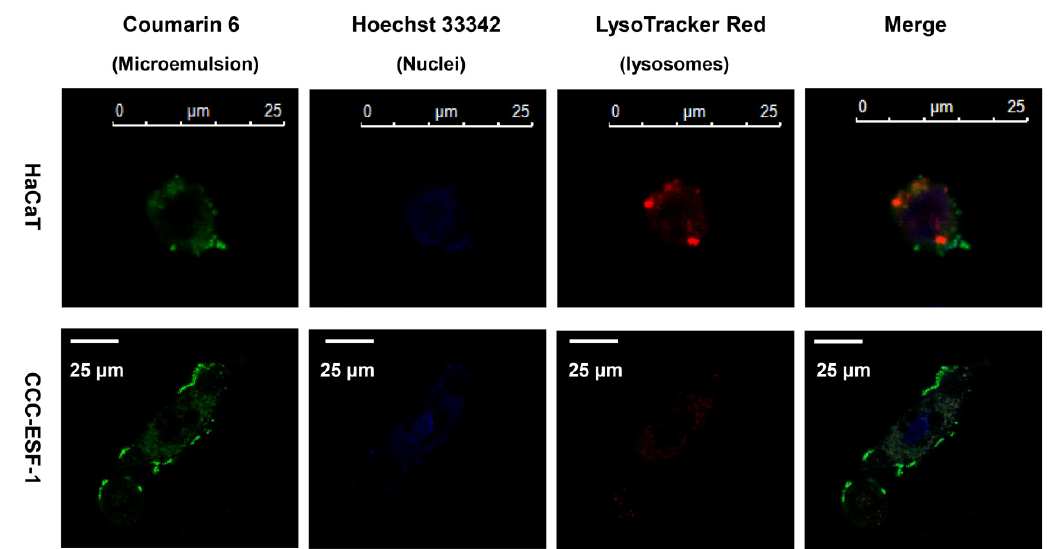
Figure 6. Intracellular localization of coumarin 6-loaded microemulsion in HaCaT and CCC-ESF-1 cells; microemulsion, nuclei, and lysosomes were labeled with coumarin 6 (green), Hoechst 33342 (blue), and LysoTracker Red (red); the yellow shows green (microemulsion) colocalized with LysoTracker Red.